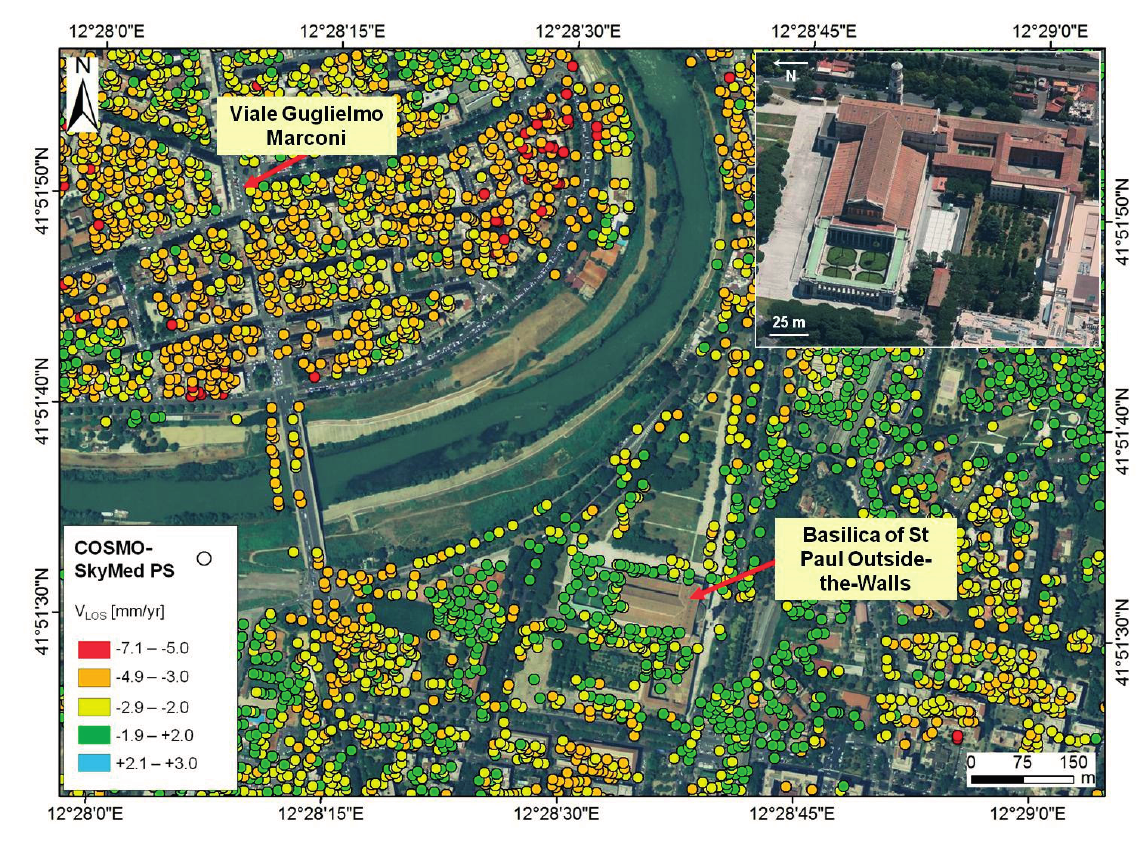
Figure 11. V LOS of the COSMO-SkyMed PS over the architectural complex of the Basilica of St. Paul Outside the Walls and the Marconi quarter ( i.e. , Nos. 17 and 19 in Figure 3a). The inset shows an aerial photograph of the basilica from BingMaps (© 2014 BLOM, © 2014 Microsoft